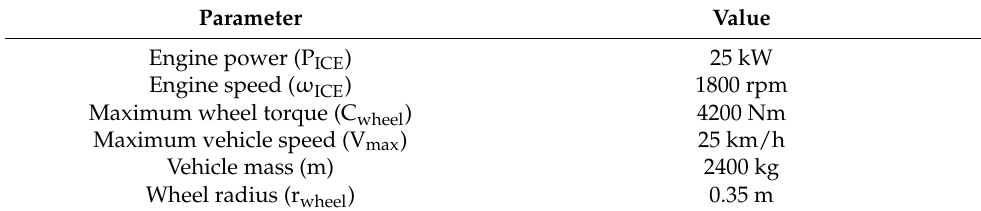
Figure 1. Overall dimensions of Dulevo sweeper 850 mini. The main features of the street sweeper are shown in Table 1. Table 1. Operating characteristics of reference vehicle.